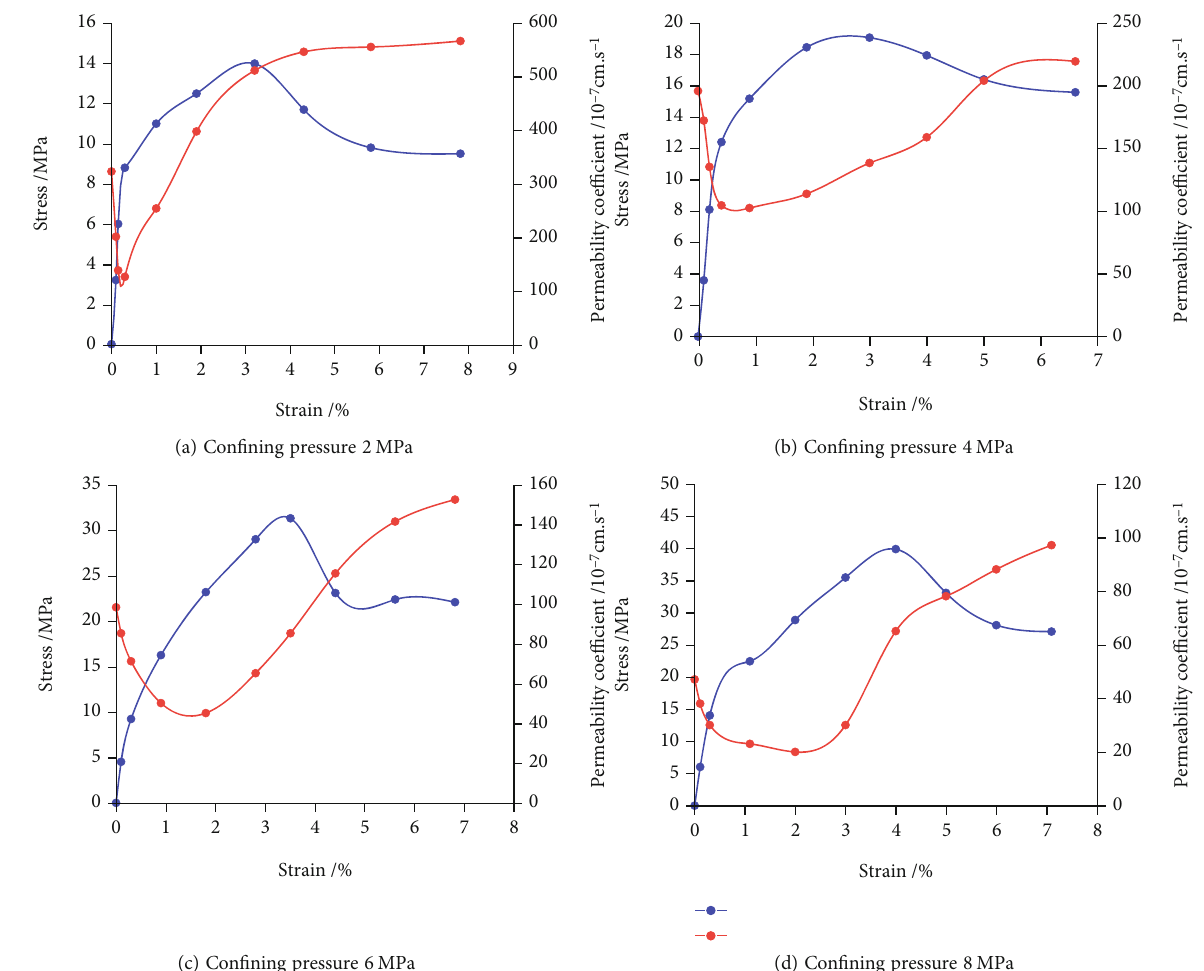
Figure 4: The relationship curve between hoop strain, permeability coe ffi cient, and